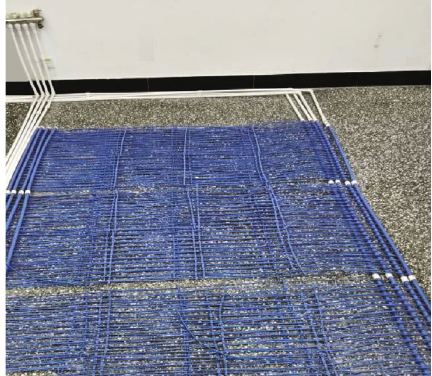
Figure 16: Physical map of the end of the